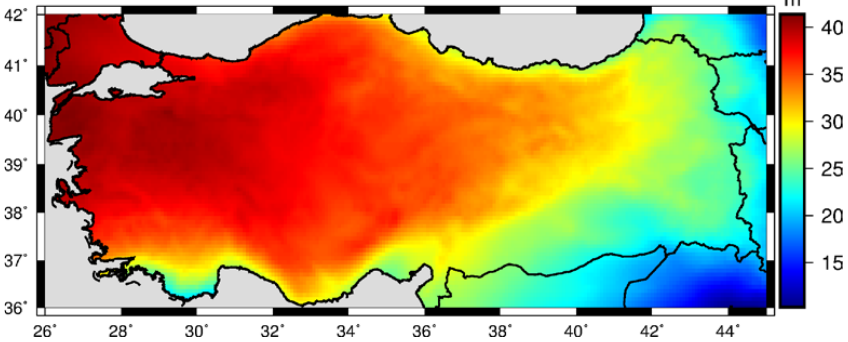
Figure 8. The experimental Turkey geoid, calculated using the remove–compute–restore (RCR) approach based on the reference geopotential model DIR-RL5.